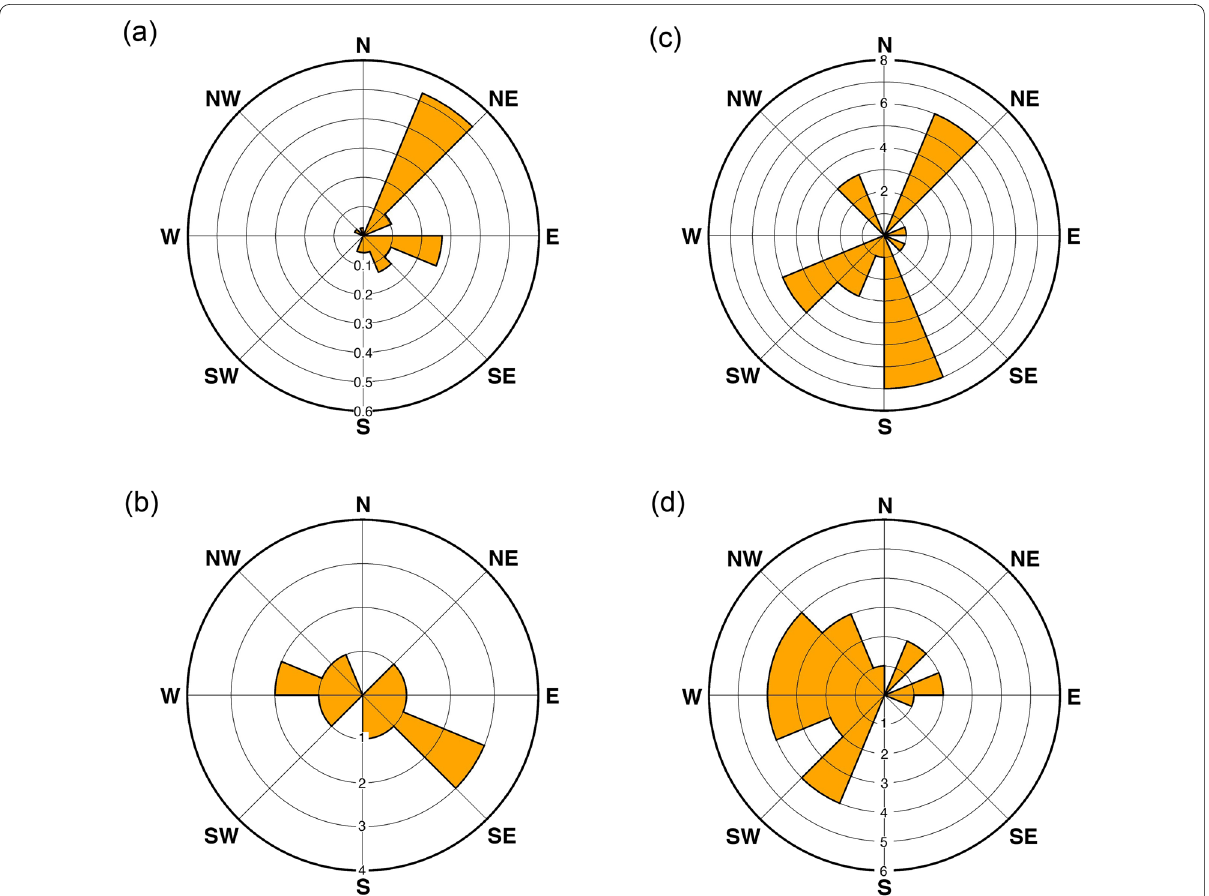
Fig. 3 Rose diagrams of a slope aspects, b dip directions, c wave propagation directions, and d surface displacement